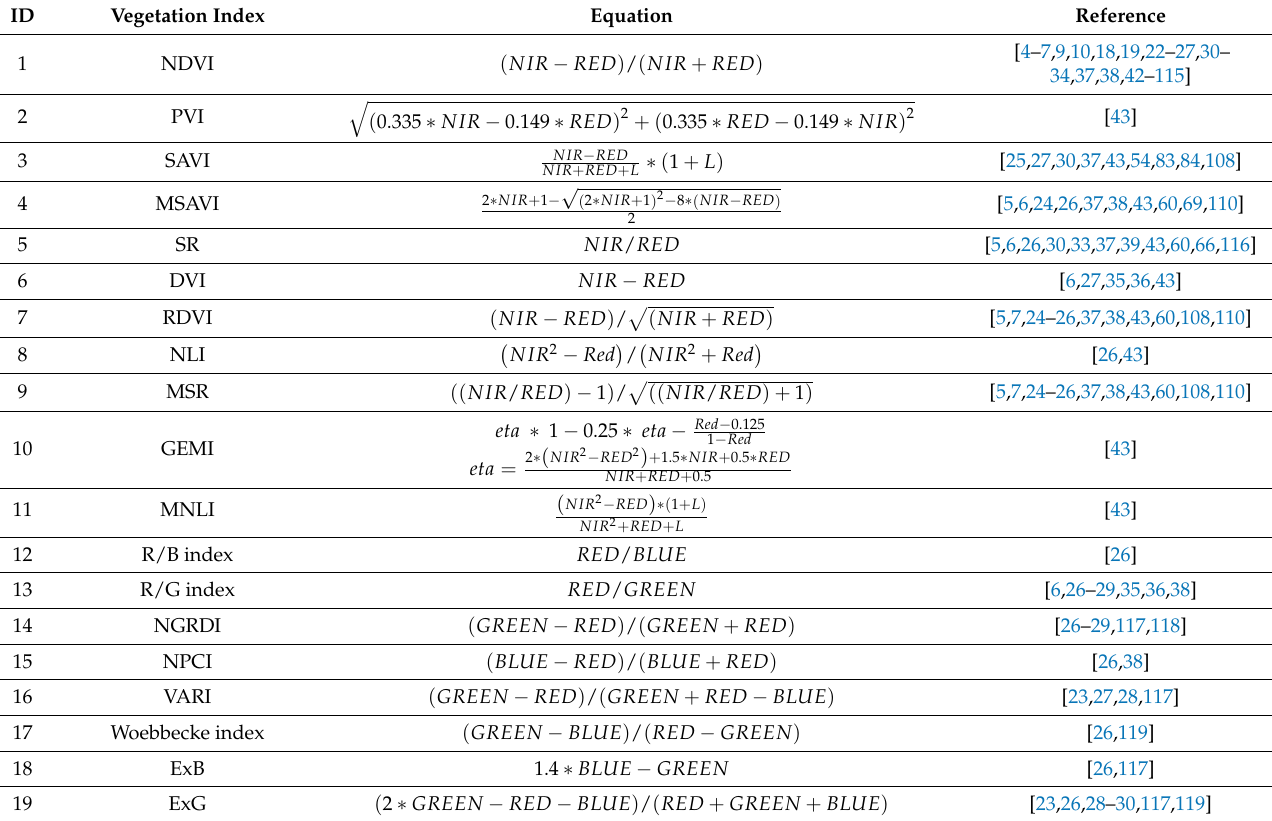
Table 4. Vegetation indices table (in hyperspectral VI’s the nominal reference has been replaced by arithmetic in nanometers).